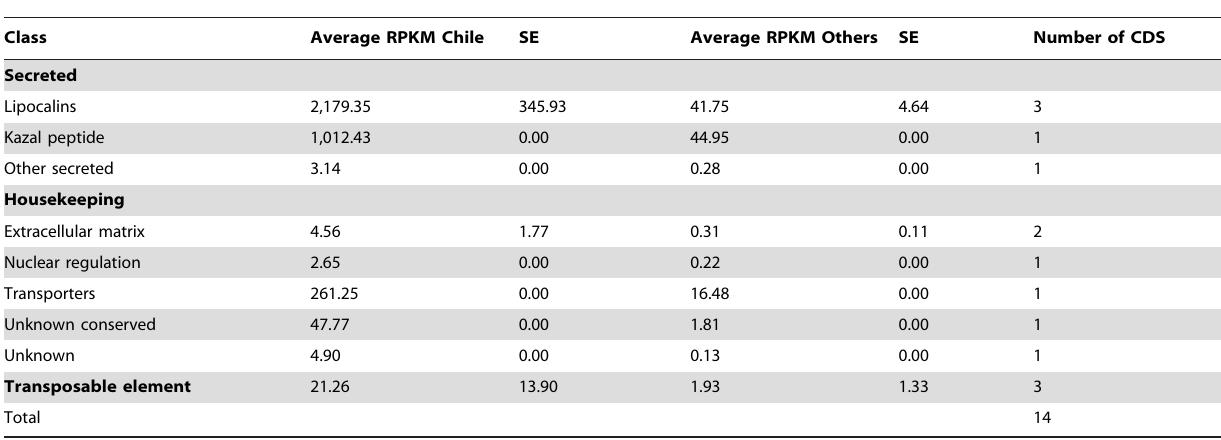
Table 10. Transcripts found overexpressed ( . 10 fold) on Chilean population.